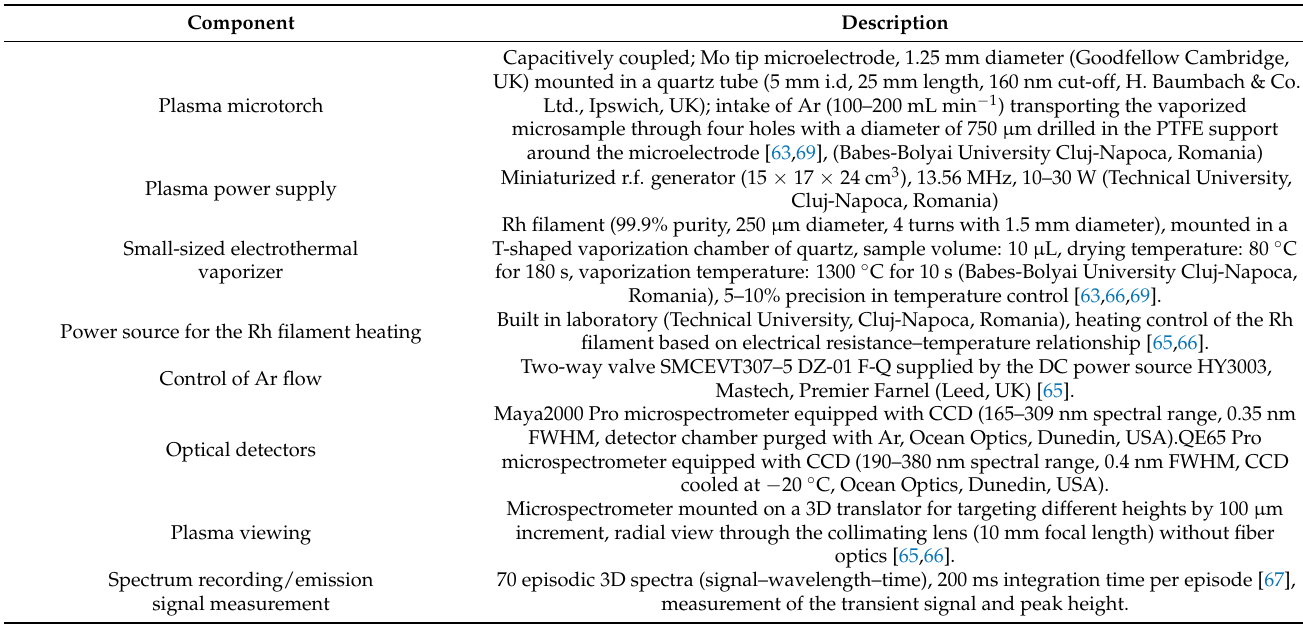
Table 7. Constructive characteristics and operation conditions of the SSETV- µ CCP-OES analytical system equipped with two low-resolution